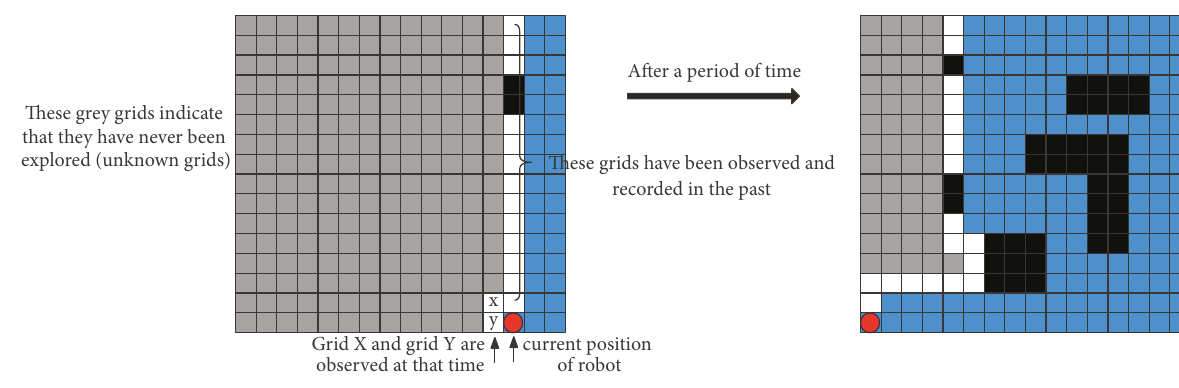
Figure 8: The unknown environment shown in the grid-based